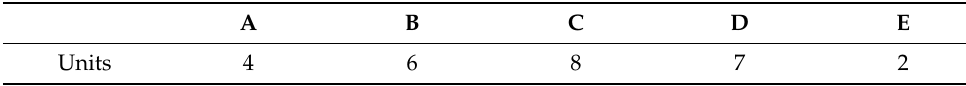
Table 3. Units required of books (A–E) by the customer. A B C D Units